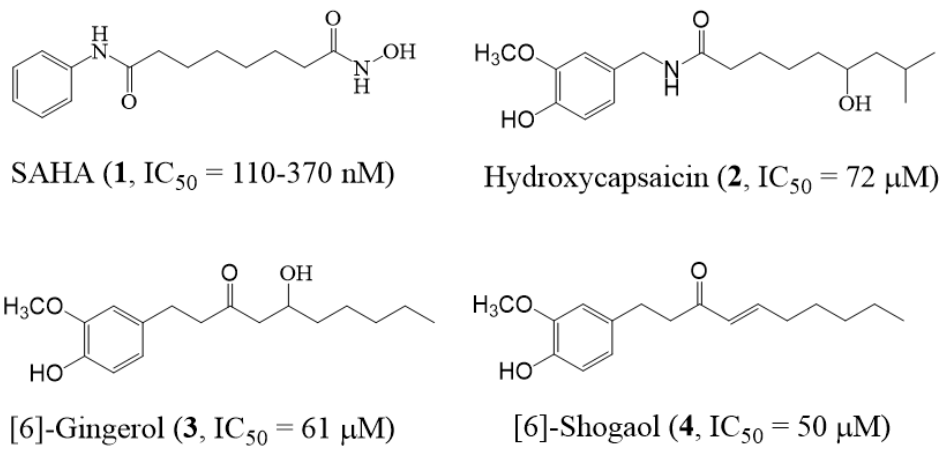
Figure 1. Structures and IC 50 values of known histone deacetylase inhibitors.